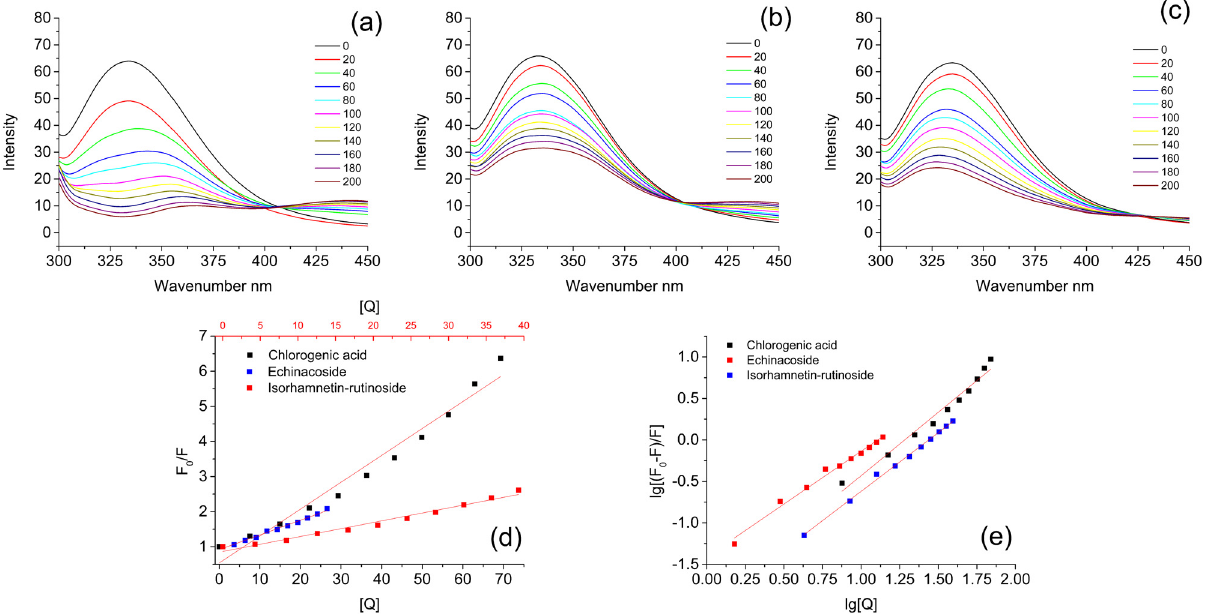
Figure 4: The quenching e ff ects of ( a ) chlorogenic acid, ( b ) echinacoside, and ( c ) isorhamnetin - rutinoside on xanthine oxidase fl uorescence spectra. λ ex = 280 nm; xanthine oxidase, 1.0 μ mol/L; the addition of inhibitors was from 10 to 100 μ mol/L. ( d ) The Stern – Volmer plots for fl uorescence quenching by three inhibitors. ( e ) The plots of lg [( F − F ) / F ] versus lg [ Q ] for three 0